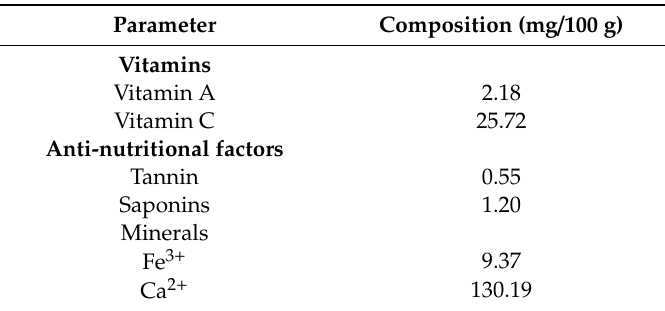
Table 3. Concentrations of some vitamins, anti-nutritional factors and minerals in AW products used in the experimental diet for